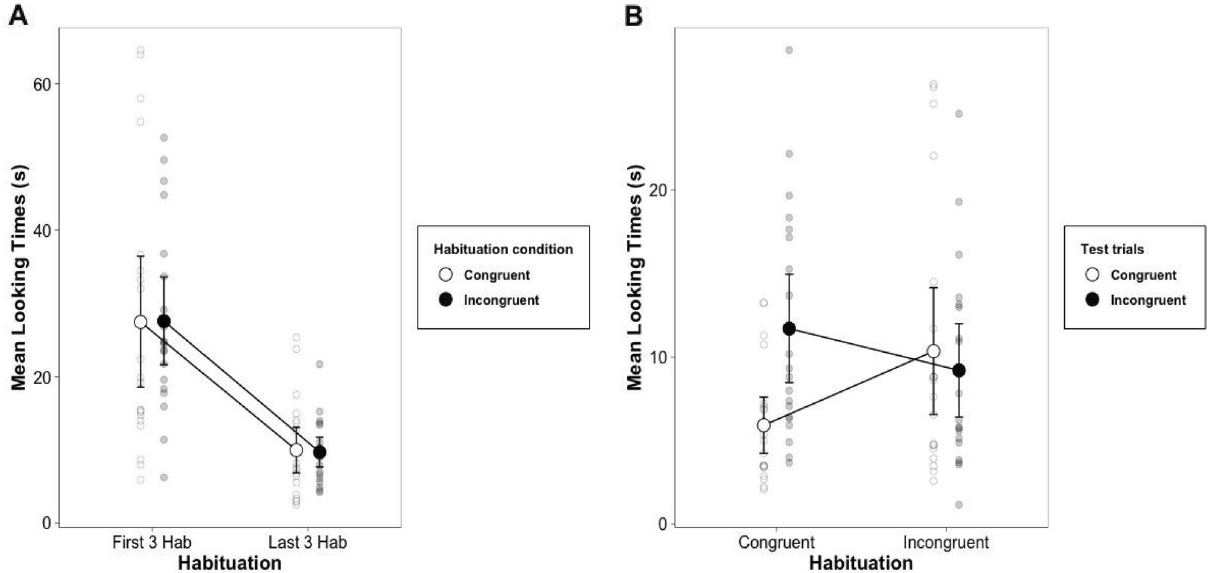
Figure 2. ( A ) Mean looking times in the congruent and incongruent habituation conditions for the first and last three trials of habituation, showing no differences across the two habituation conditions. ( B ) Mean looking times in the first and last three habituation trials for the two test-trials, showing a significant looking time difference between the two test-trials for infants habituated to the congruent condition, and no difference for infants habituated to the incongruent condition. Error bars represent 95% confidence